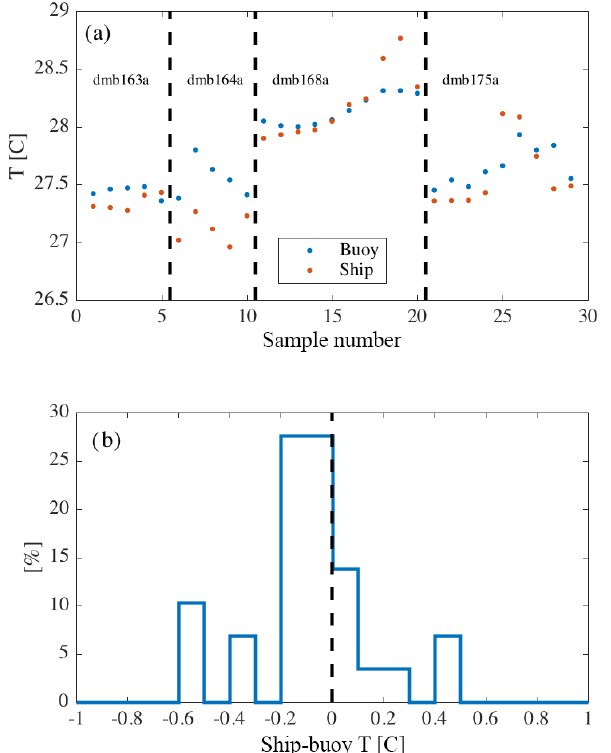
Figure 14. Comparisons between the air temperatures measured by the ship and by a buoy when the ship was within 0.1 ◦ lati- tude/longitude of the buoy. All data are 10min averages; ship mea- surements are from 15m and buoy measurements from 3m a.s.l. (a) All available observation pairs, with dashed vertical lines sepa- rating buoys: dmb163a (9 ◦ N, 140 ◦ W), dmb164a (5 ◦ N, 140 ◦ W), dmb168a (5 ◦ S, 140 ◦ W), and dmb175a (8 ◦ N, 125 ◦ W). (b) The distribution of all differences between those pairs.